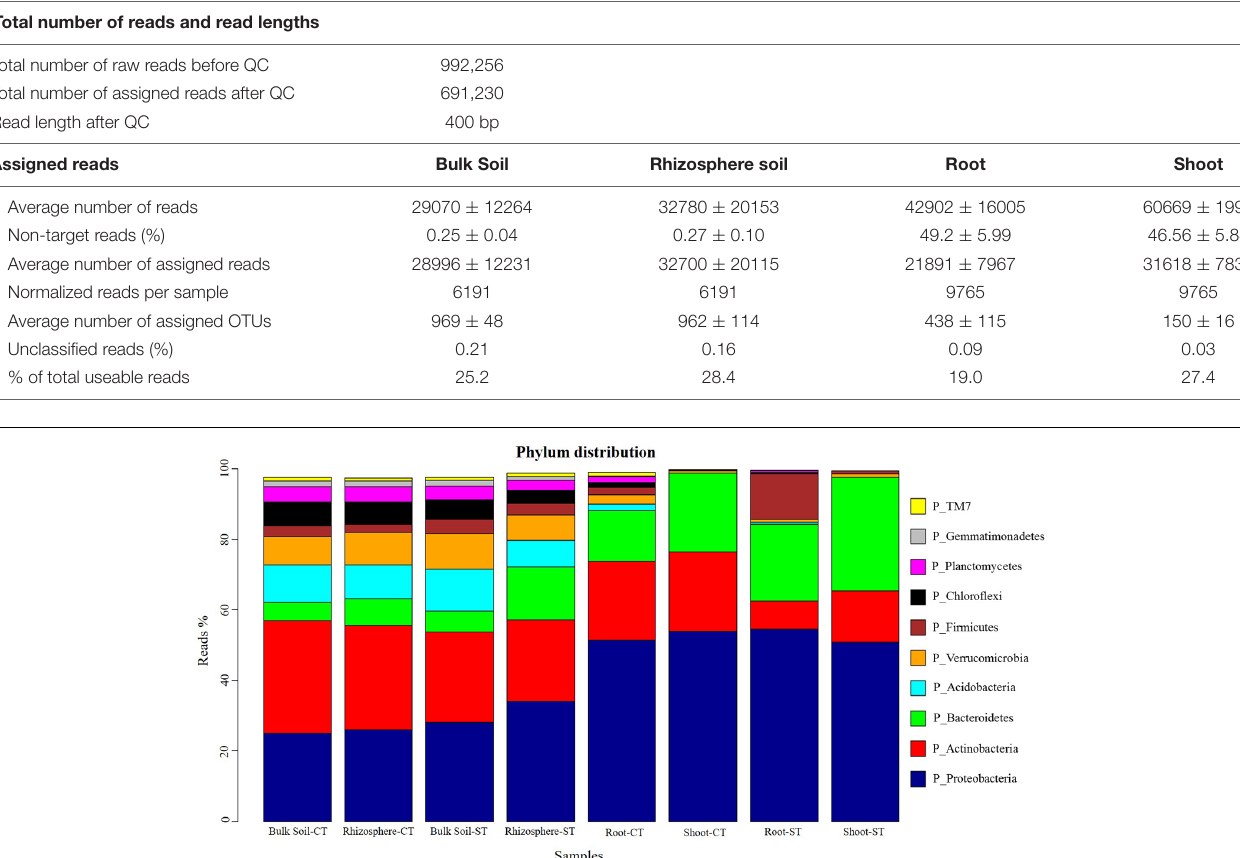
TABLE 1 | Quality metrics for sequencing data.